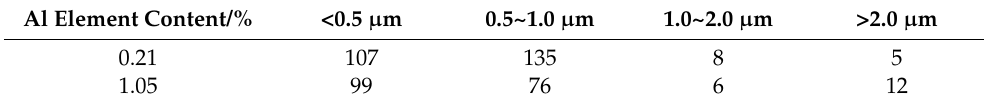
Table 5. Size distribution of inclusion in weld metal